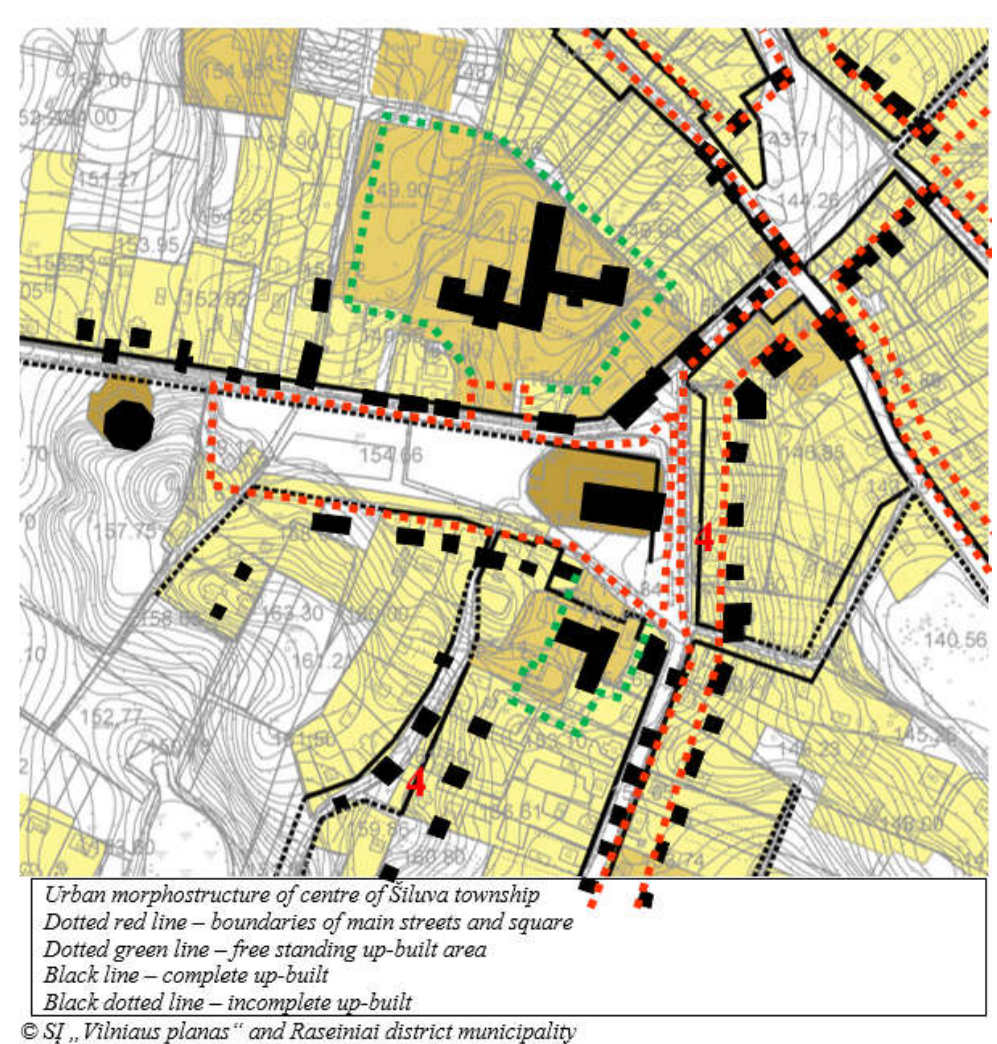
Figure 3. Present built-up environment around the religious central square.